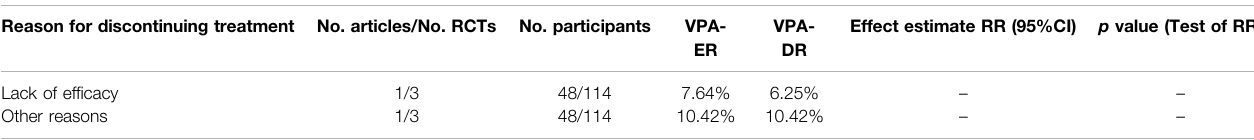
TABLE 6 | Reason for discontinuing treatment (VPA-ER.vs.VPA-DR). Reason for discontinuing treatment No. articles/No. RCTs No. participants